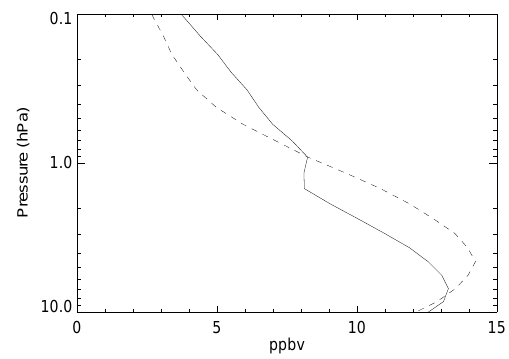
Figure 7. Monthly averaged WACCM/NOGAPS NO x ( = NO + NO 2 for June 2009 (solid) and 2008 (dashed) at 75 ◦